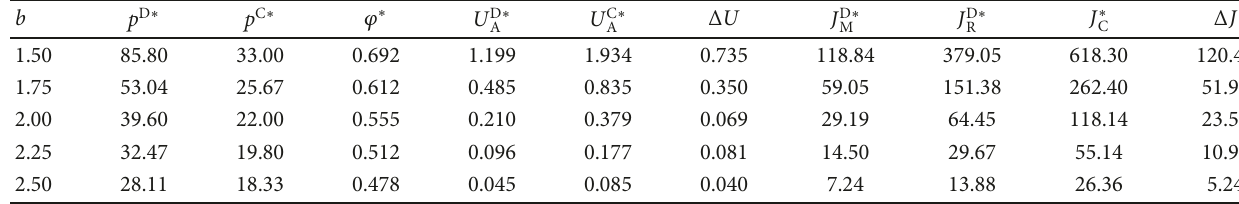
Table 2: The impact b onto the decisions and pro fi